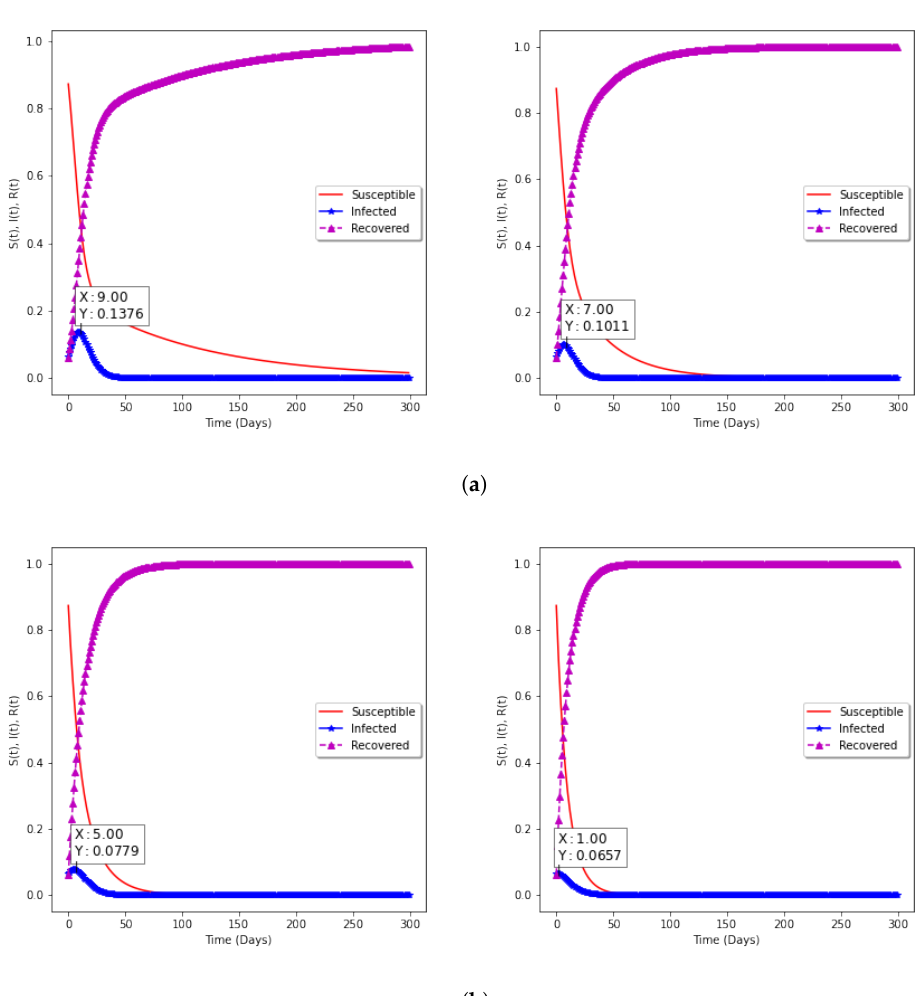
Figure 9. Model with vaccination. ( a ) Vaccination rate of 1% and 3%; ( b ) Vaccination rate of 6% and 10%.